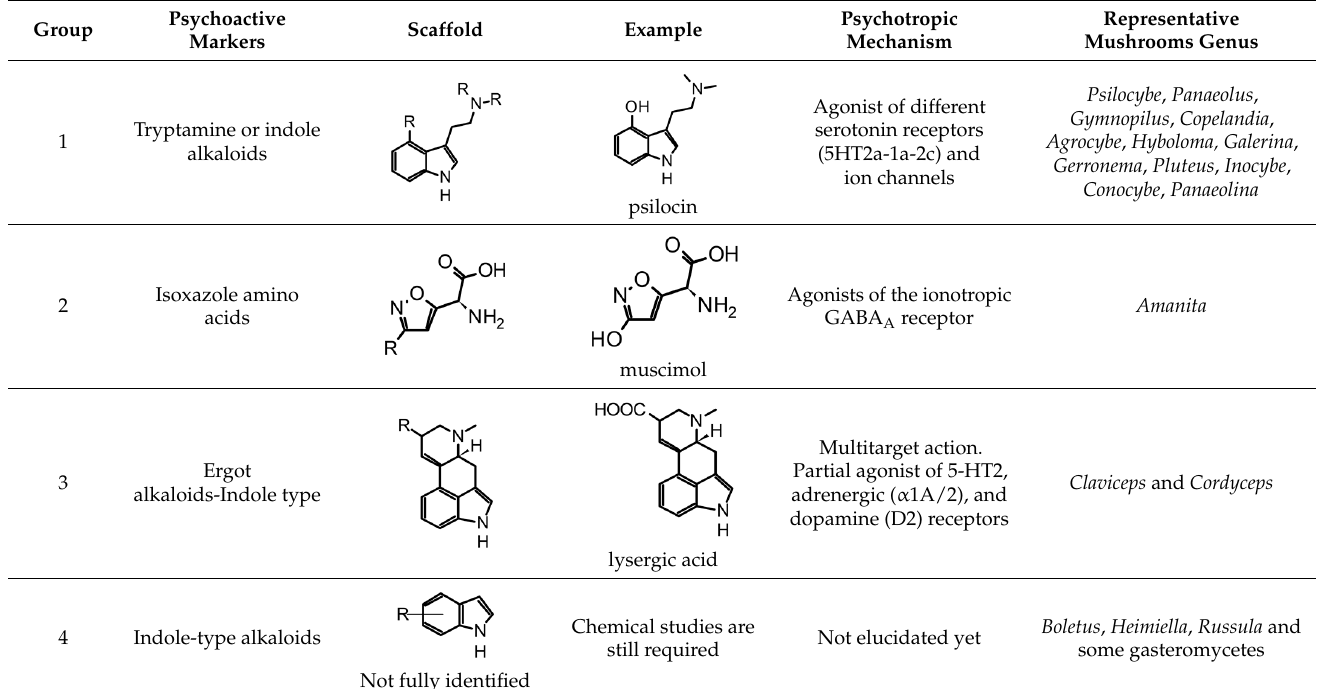
Table 2. Classification of psychoactive mushrooms, bioactive markers, and psychotropic mechanism according to Guzman et al. [42].